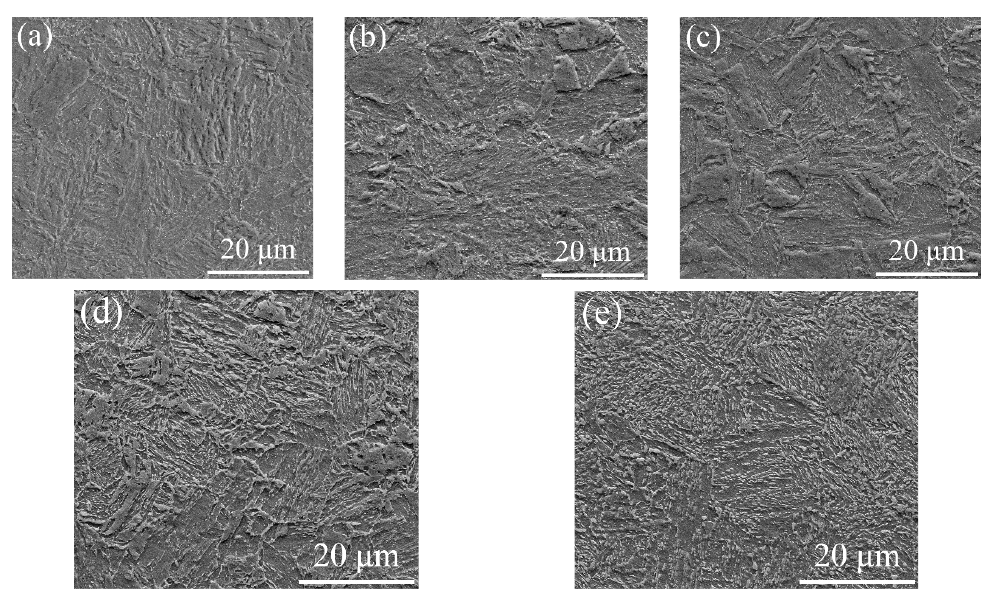
Figure 4. SEM images: ( a ) 550 °C; ( b ) 580 °C; ( c ) 600 °C; ( d ) 620 °C; ( e ) 650 °C.